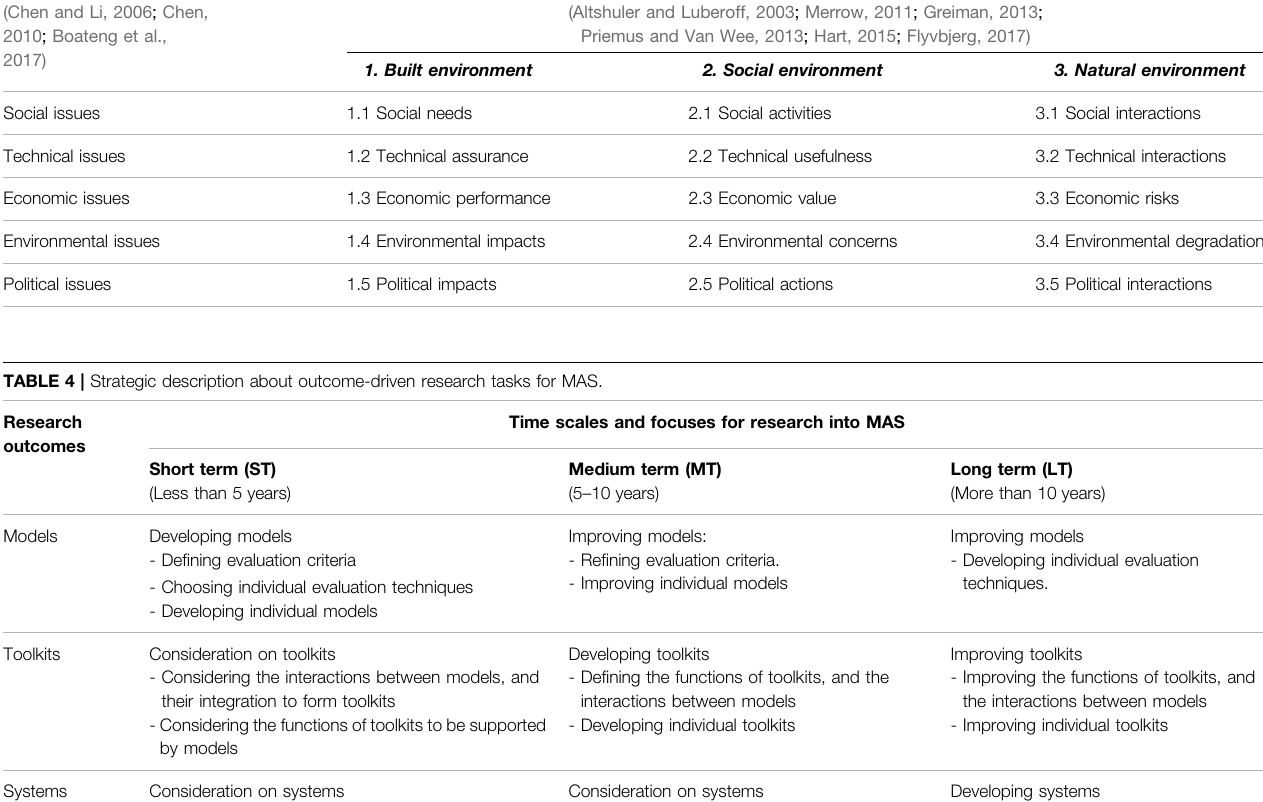
TABLE 3 | MAS-oriented research themes and areas within MSBOK framework. STEEP themes (Chen and Li, 2006; Chen, 2010; Boateng et al., 2017)